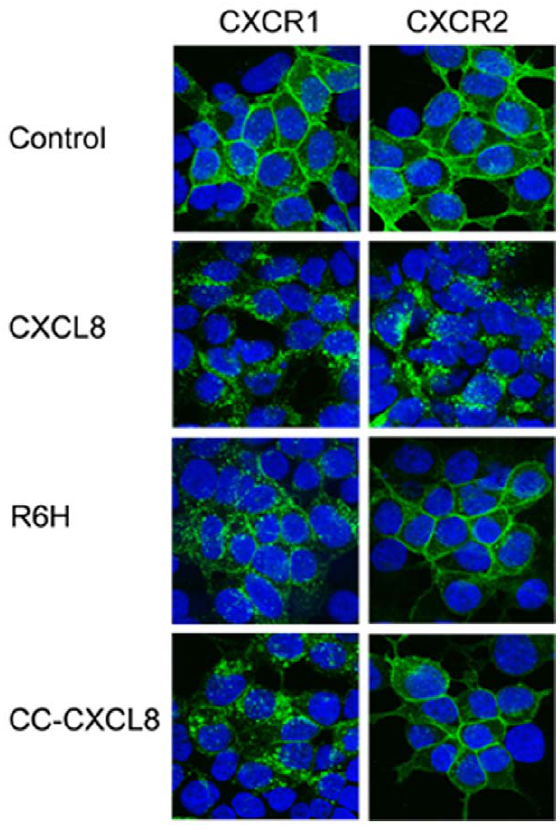
Figure 3. R6H-CXCL8 and CC-CXCL8 mutants triggered inter- nalization of CXCR1. HEK 293 cells were transiently transfected with plasmids encoding CXCR1 or CXCR2 fused to GFP. Transfected cells were treated with 100 nM of CXCL8, R6H-CXCL8 or CC-CXCL8 mutants for 30 min at 37 u C. Fluorescence was recorded by using a confocal